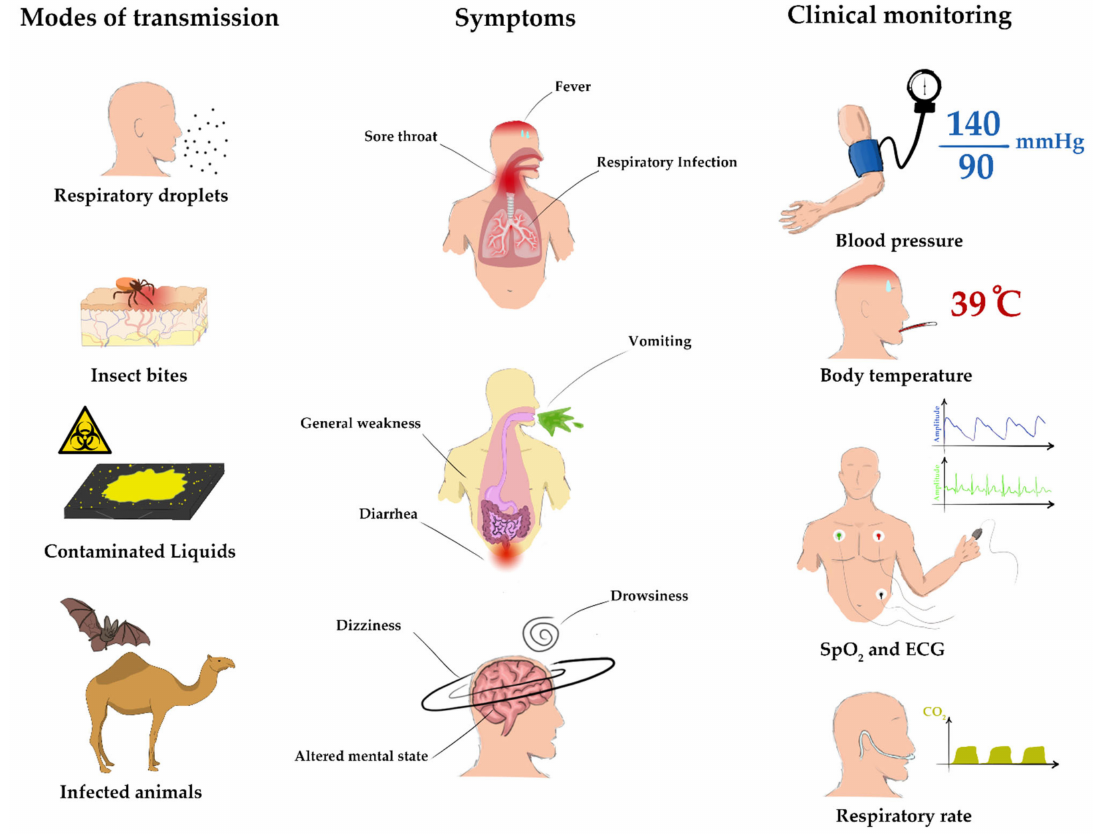
Figure 2. Summary of modes of transmission, symptoms, and clinical management for the infectious diseases mentioned in this study. Symptoms are categorized into three categories: respiratory, digestive, and